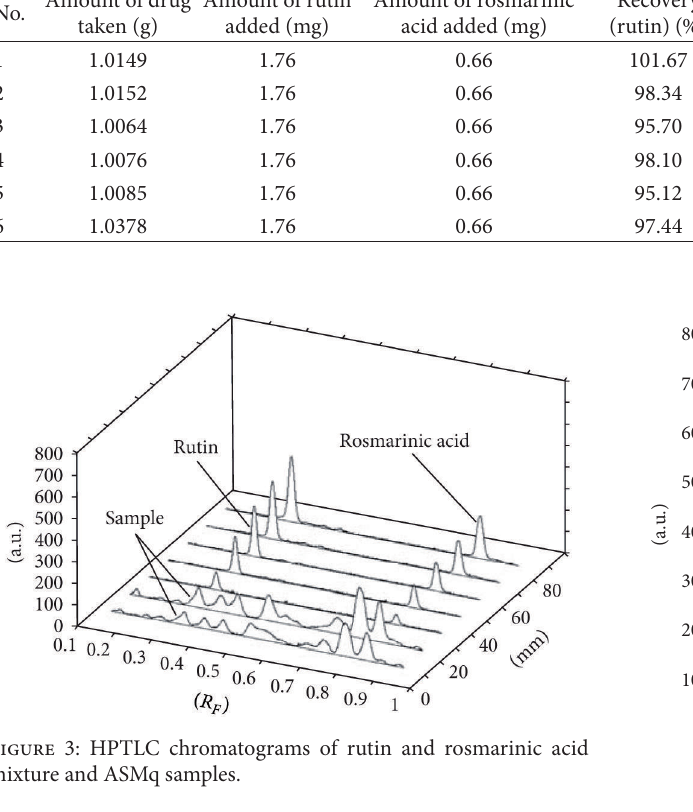
F 5: HPTLC chromatograms of rutin and rosmarinic acid mixture in ASMq.